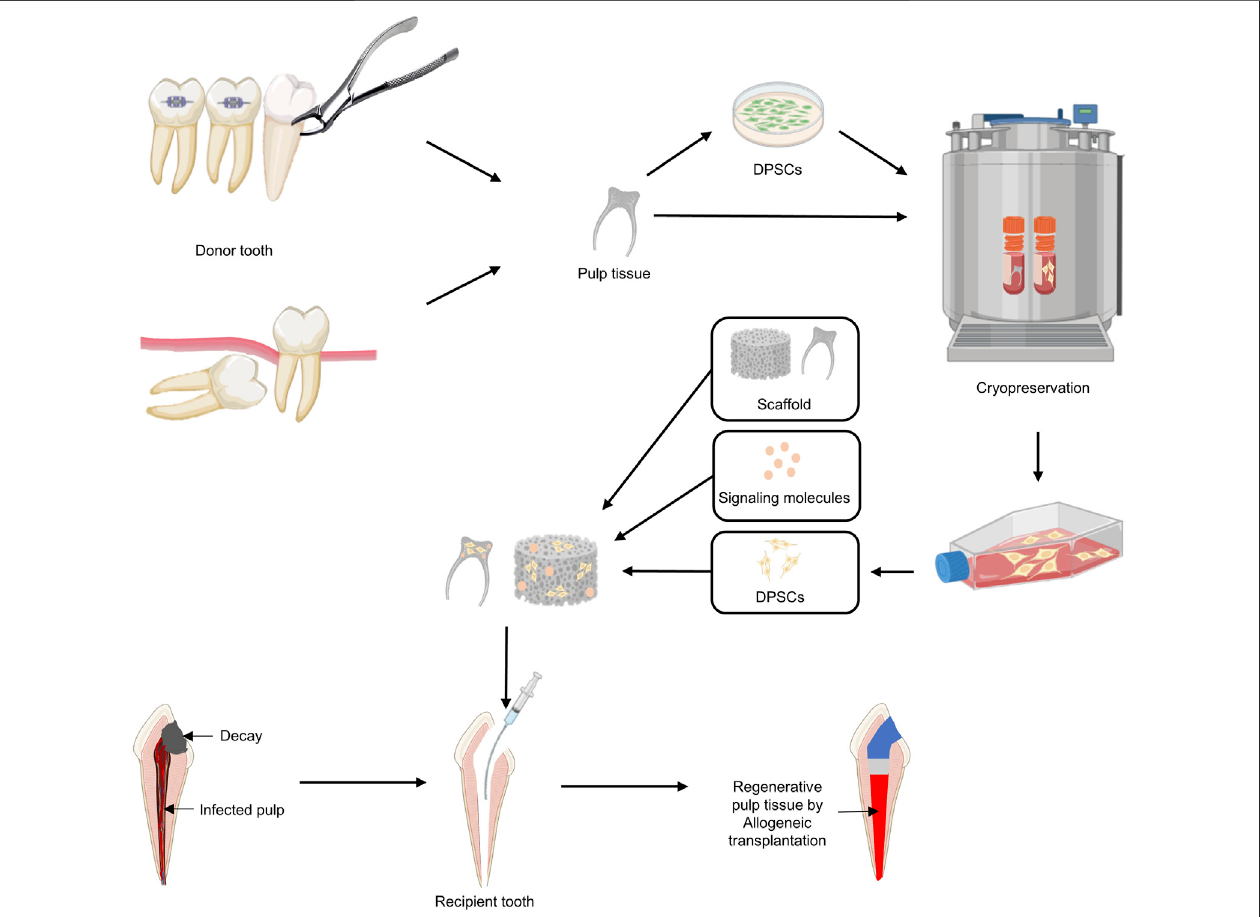
FIGURE 5 | A proposed strategy using allogeneic DPSC transplantation for pulp regeneration. 1) Dental pulp tissue is removed from an uninfected orthodontic extractiontoothorwisdomtooth(donor).2)AfterisolatingandculturingDPSCsfromdentalpulp,cryopreservationofDPSCsordentalpulpitselfisperformed.3)DPSCs areexpandedusingcryopreservedDPSCsordentalpulptissuesaccordingtothepatient ’ streatmentplanforpulpectomy.4)SignalingmoleculesandDPSCsareadded to the appropriate scaffold and applied to the disinfected pulp space.